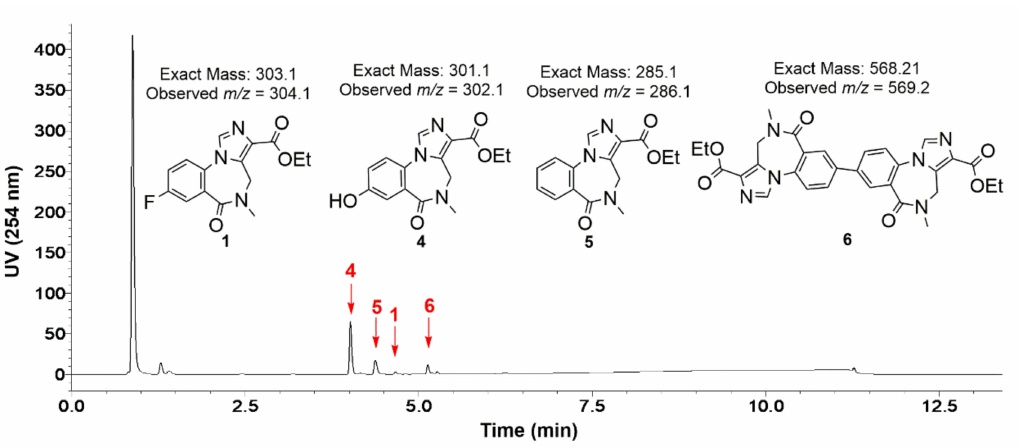
Figure 4. LC-MS/MS analysis of major by-products that were formed in the crude reaction mixture of [ 18 F]FMZ 1 at 120 ◦ C after 10 min reaction